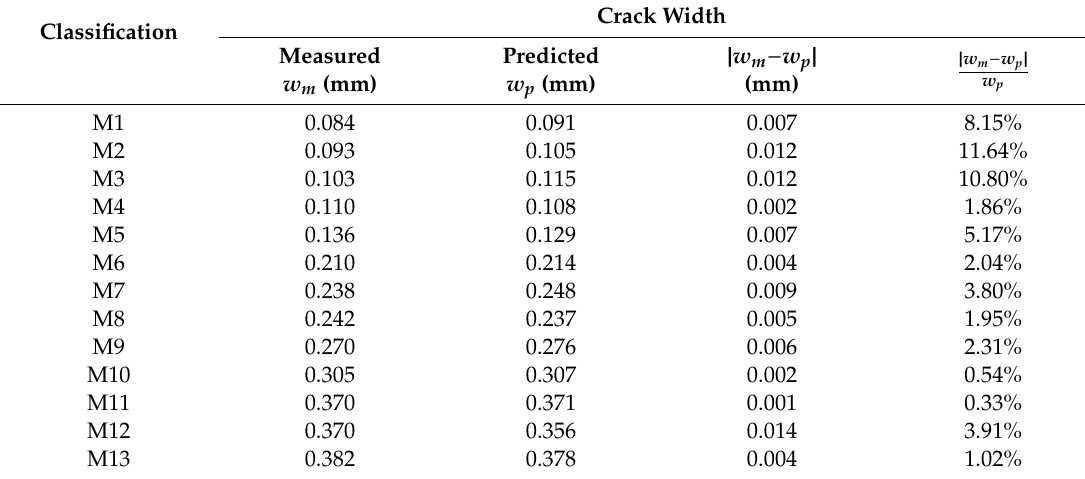
Table 4. Predicted crack width of mortar